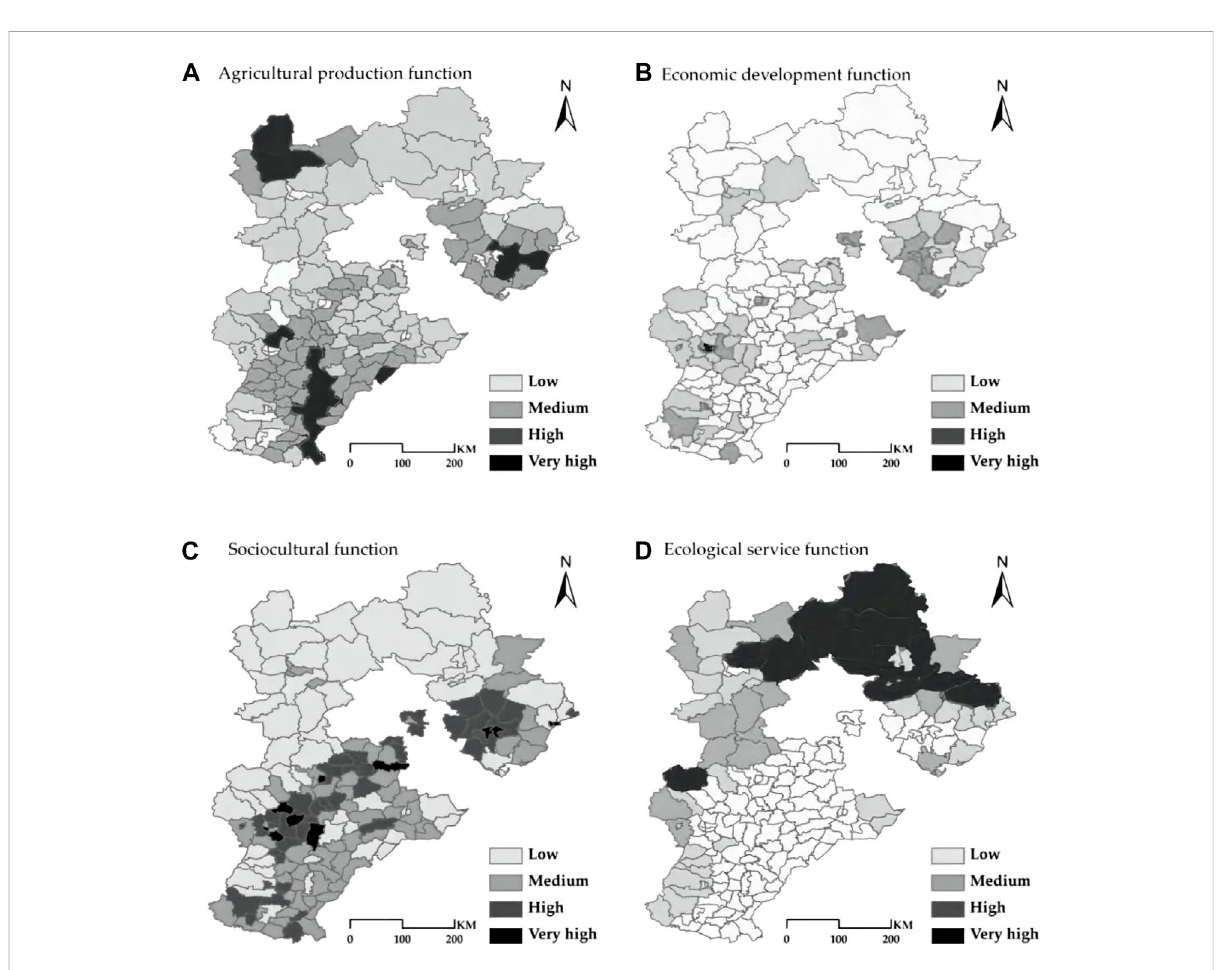
FIGURE 2 Spatial differentiation of rural-area multi-functionality in Hebei